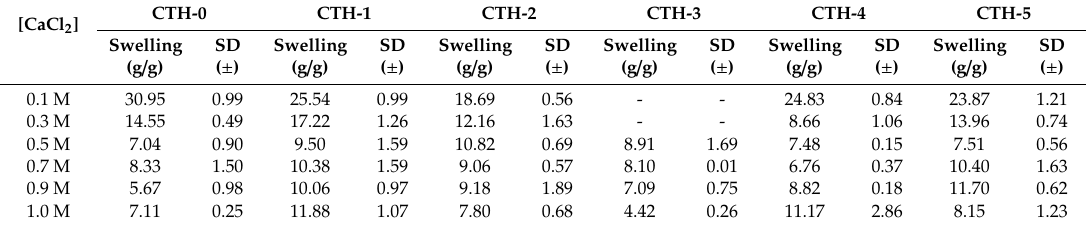
Data showing swelling behaviour of CS / PAH films in CaCl 2 solutions of variable molar